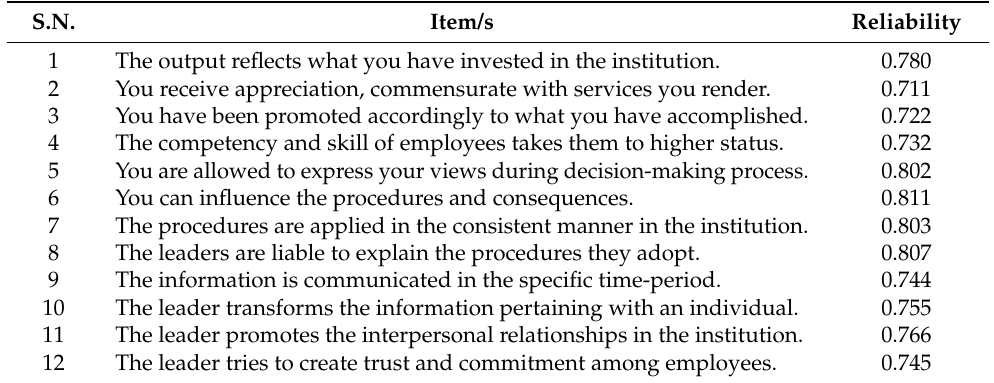
Table 2. Items for organizational